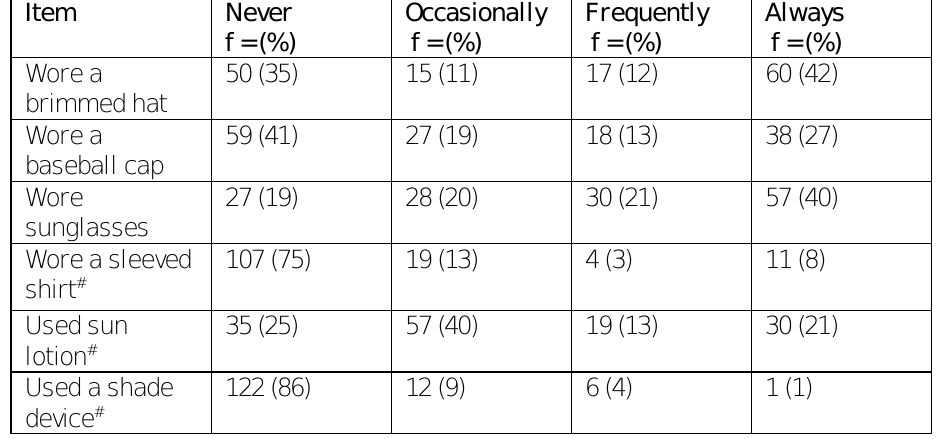
Table 1: Frequencies and percentages for sun protective behaviour at work